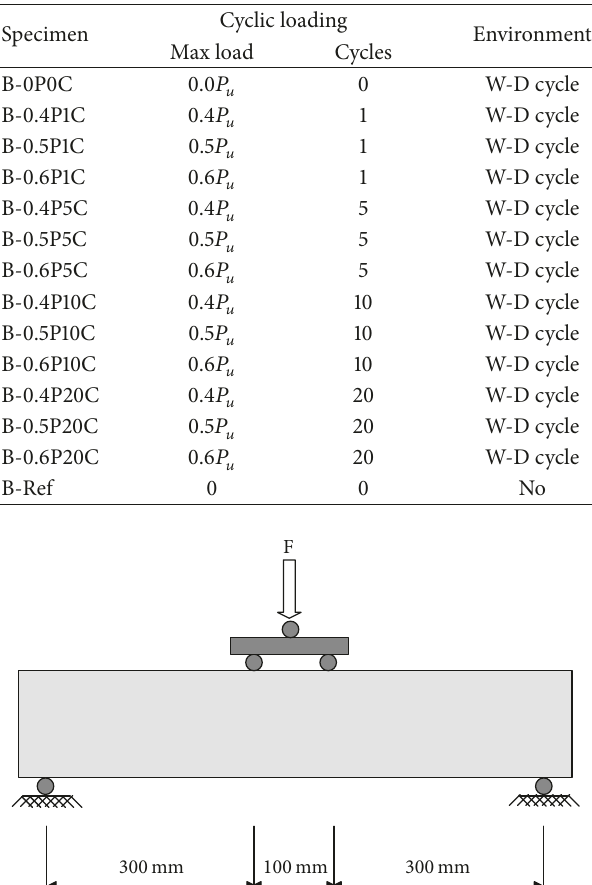
Table 2: Test condition of beam specimens.